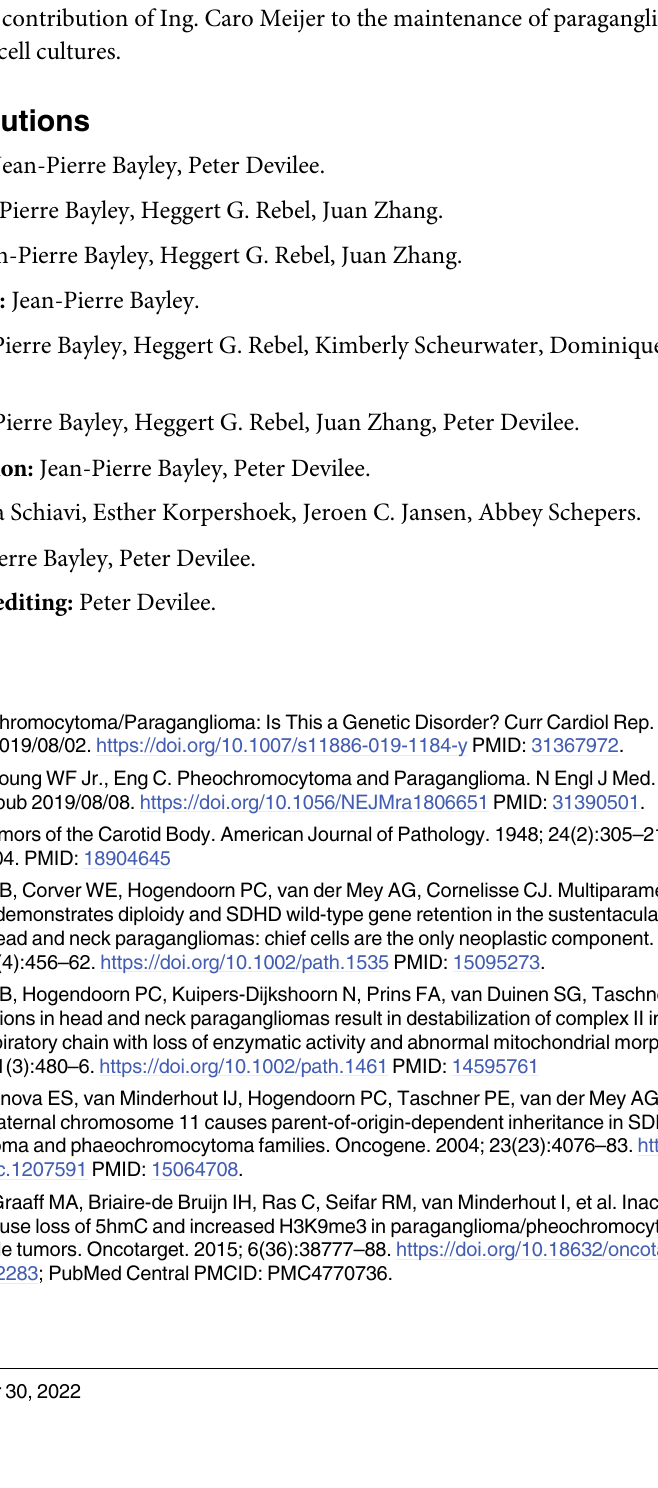
S2 Table. Immunocytochemical scoring of control cell lines and a range of PGL tumour cultures based on morphological criteria. S3 Table. Estimated (not scored) percentages of Immunocytochemical-positive cells in pri- mary PGL